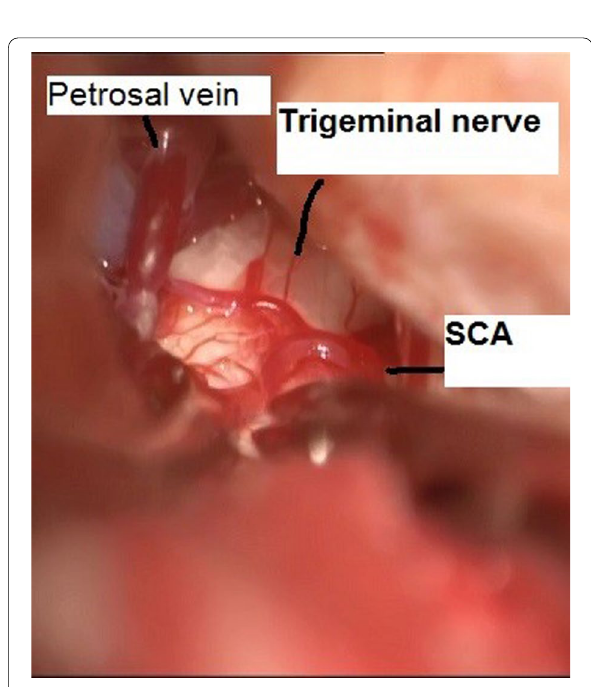
Fig. 5 An intraoperative picture during MVD showing the SCA exerting compression on the right trigeminal